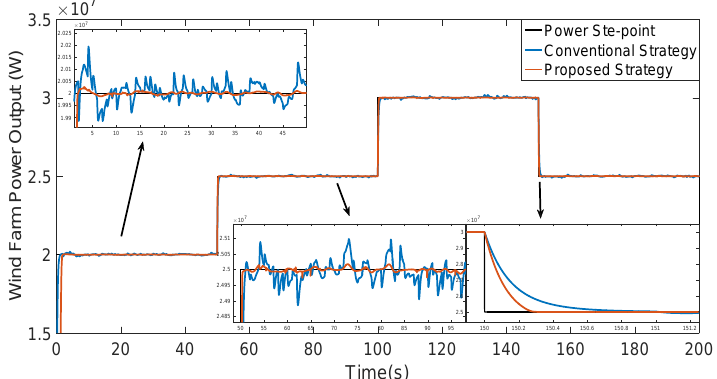
Figure 7. Wind farm output power